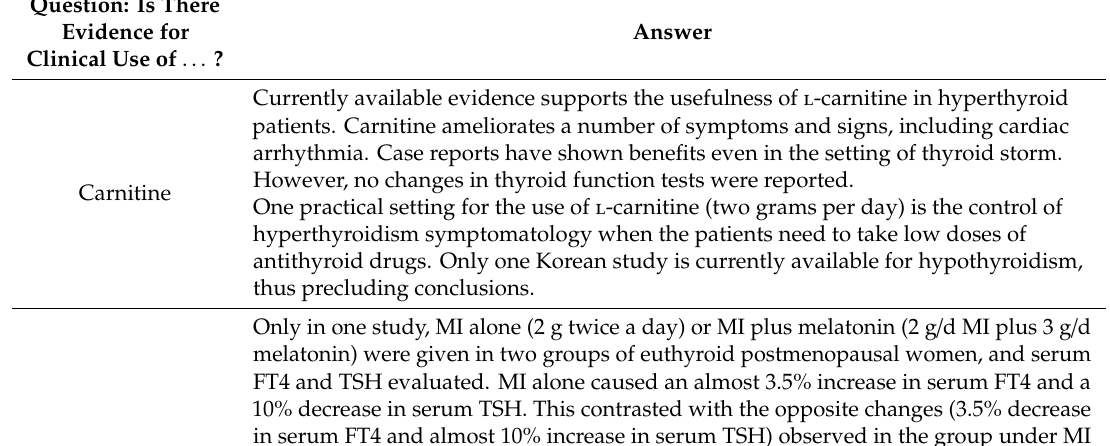
Table 4. Summary of evidence for clinical use of the nutraceuticals reviewed here in the thyroid setting *. Question: Is